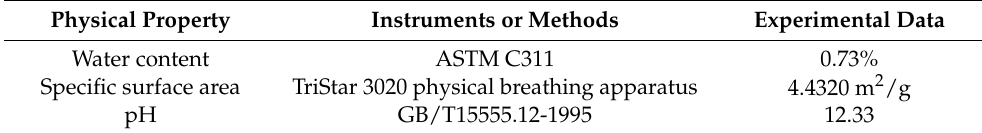
Table 2. The physical properties of fly ash.